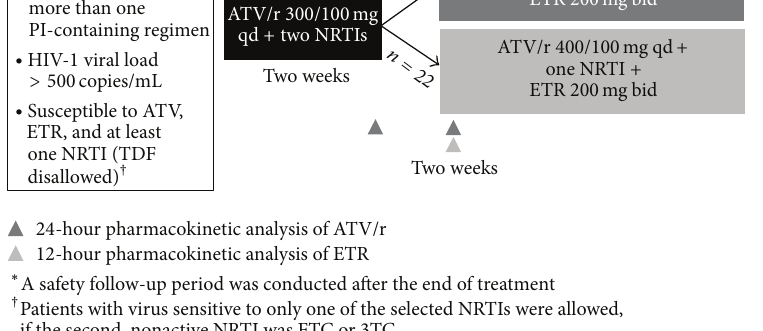
Figure 1: TEACH study design. TEACH was an open-label, randomized, exploratory Phase II trial. A two-week pretreatment period was followed by 48 weeks of treatment. 3TC: lamivudine; ARV: antiretroviral; ATV/r: atazanavir/ritonavir; ETR: etravirine; FTC: emtricitabine; NRTI: nucleoside reverse transcriptase inhibitor; PI: protease inhibitor; TDF: tenofovir disoproxil fumarate.